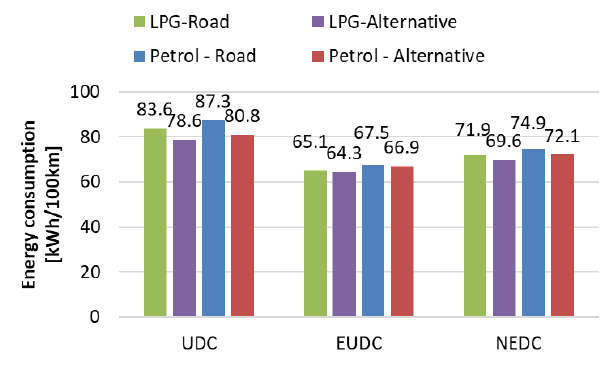
Fig. 16. Impact of resistance forces on energy consumption